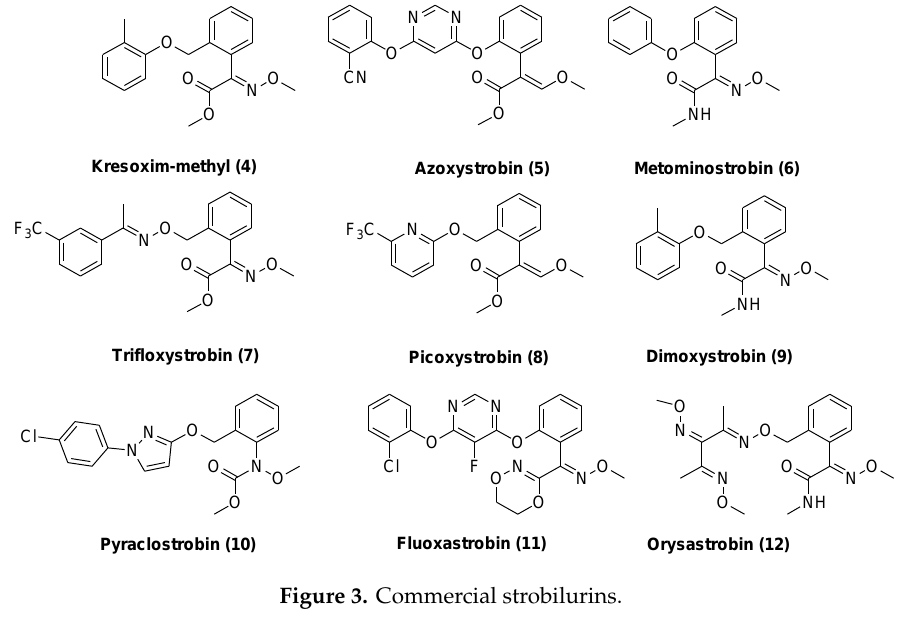
Figure 3. Commercial strobilurins.